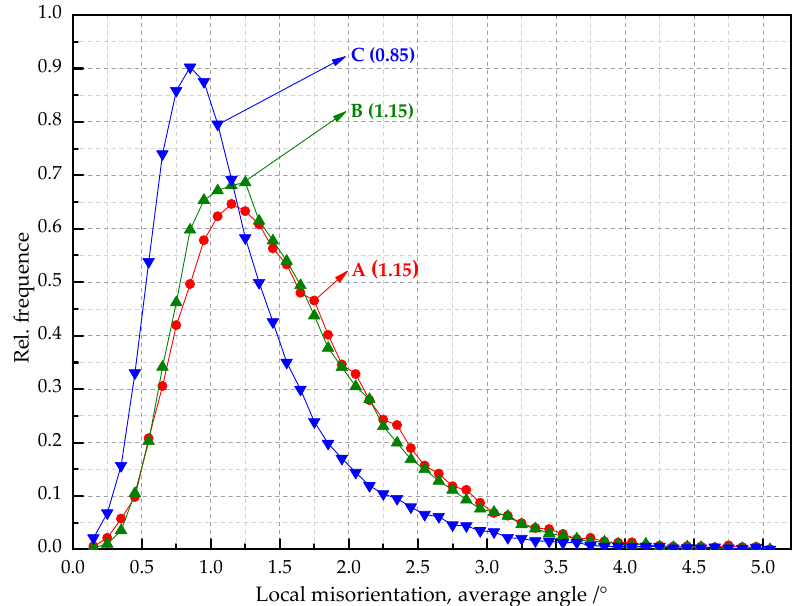
Figure 7. Distribution curves of local misorientation with different secondary cold reduction rates.